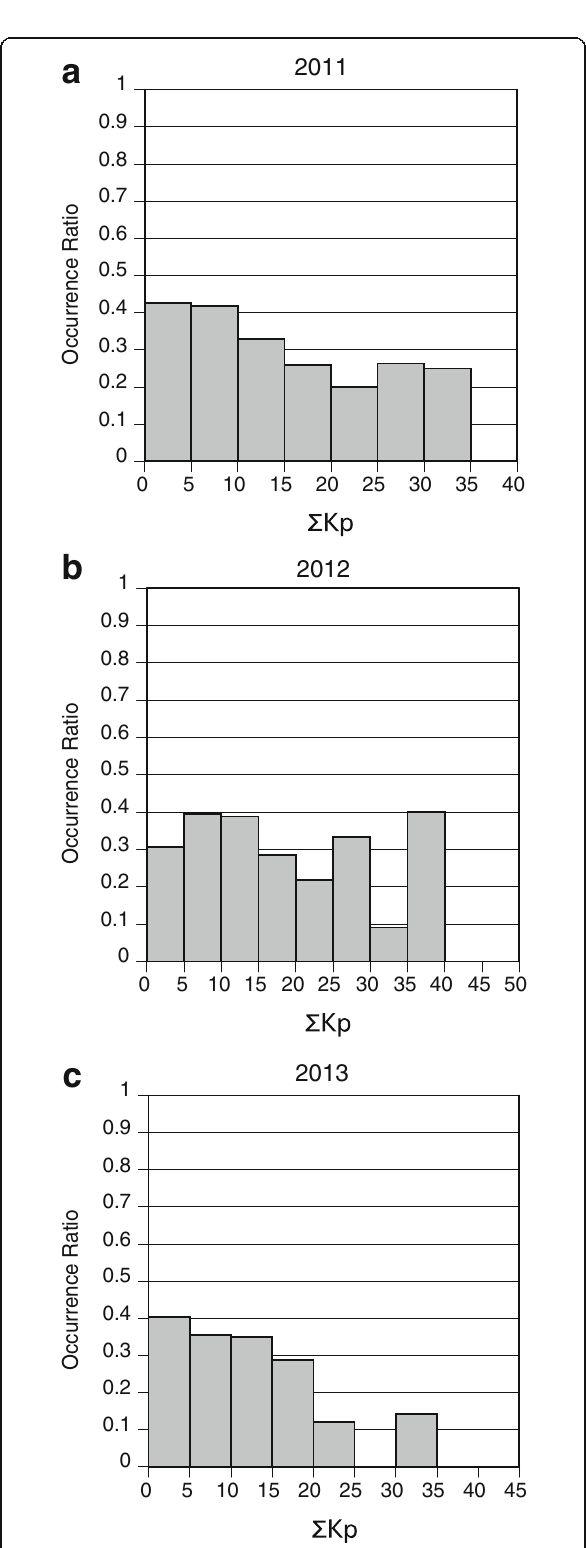
Fig. 9 Histograms of the ratio of EPB occurrence for Σ Kp . The histograms indicate the relationship between the EPB occurrence ratio and Σ Kp in a 2011, b 2012, and c